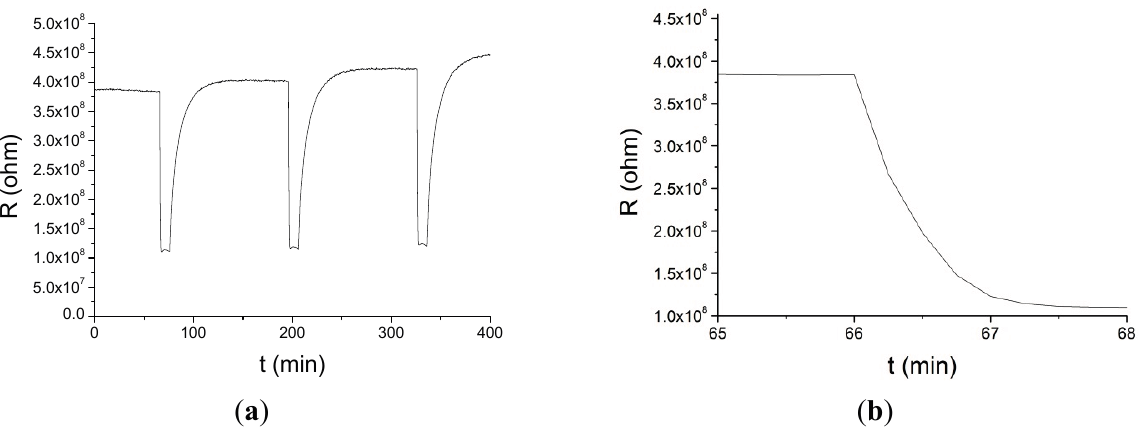
Figure 7. ( a ) Response of a nanofiber sensor with 90 s deposition time and 450 °C annealing temperature to 5 ppm of acetone at 400 °C; ( b ) expanded area around the first adsorption